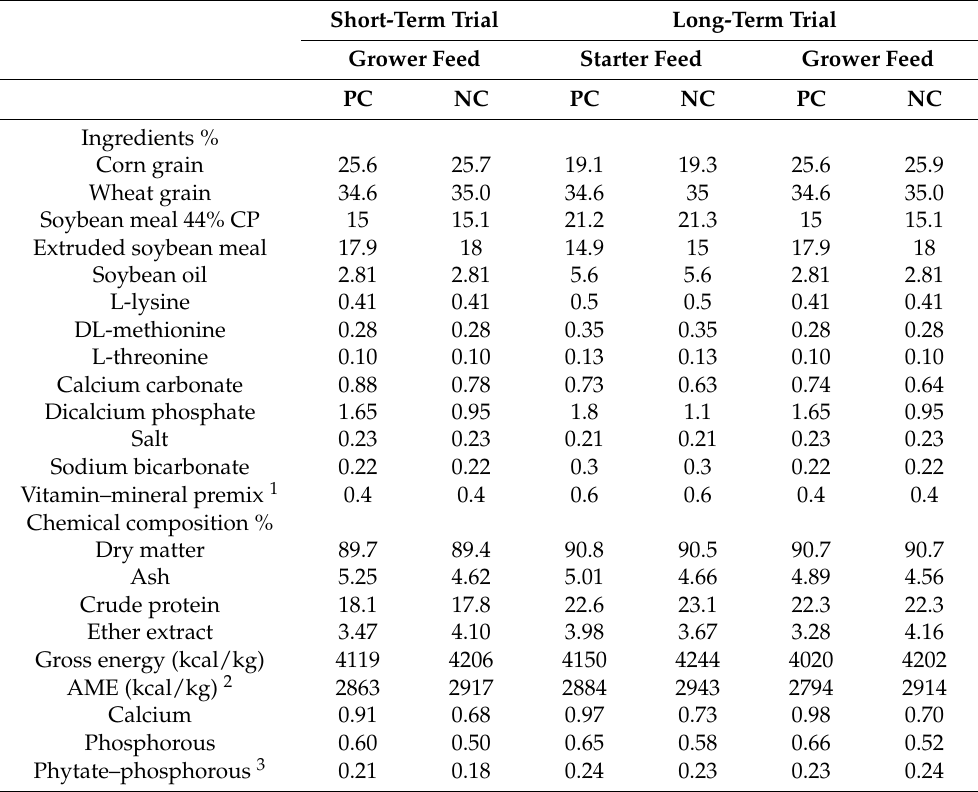
Table 1. Ingredients and analyzed chemical composition of positive control (PC) and negative control (NC) diets (% as-fed basis) in short- and long-term trials. Short-Term